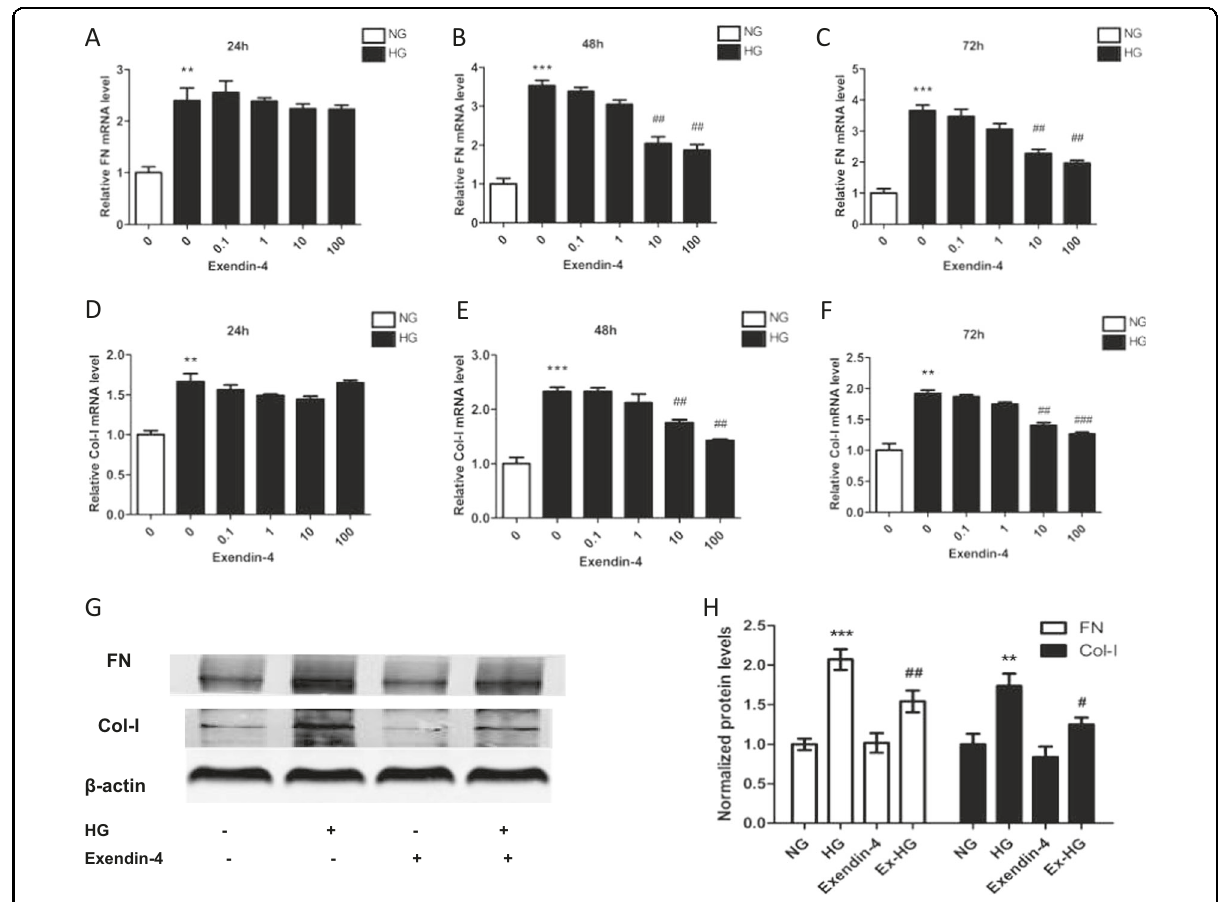
Fig. 1 Effect of exendin-4 on fi brosis in HG-induced HK-2 cells. HK-2 cells were cultured in DMEM with 5.6 mM glucose (NG) or 30 mM glucose (HG) and different concentrations of exendin-4. a – f Relative expression of FN and Col-I in HK-2 cells after incubation with HG and various concentrations of exendin-4 for 24, 48, and 72 h. g , h FN and Col-I expression in HK-2 cells after incubation with HG and 10 nM exendin-4 for 48 h was analyzed by western blot (** P < 0.01 and *** P < 0.001 versus the NG group; # P < 0.05, ## P < 0.01, and ### P < 0.001 versus the HG